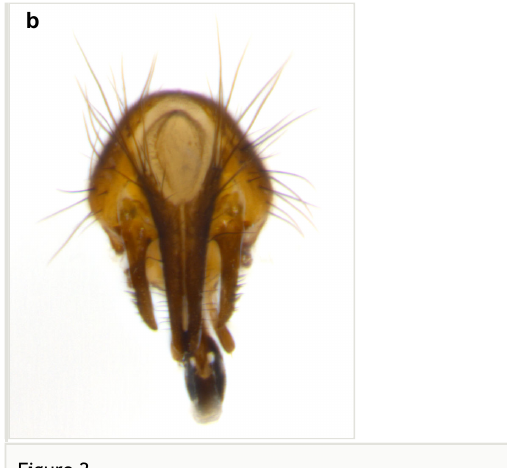
Male terminalia of Calolydella adelinamoralesae sp. n. ; a–c : paratype, voucher n.